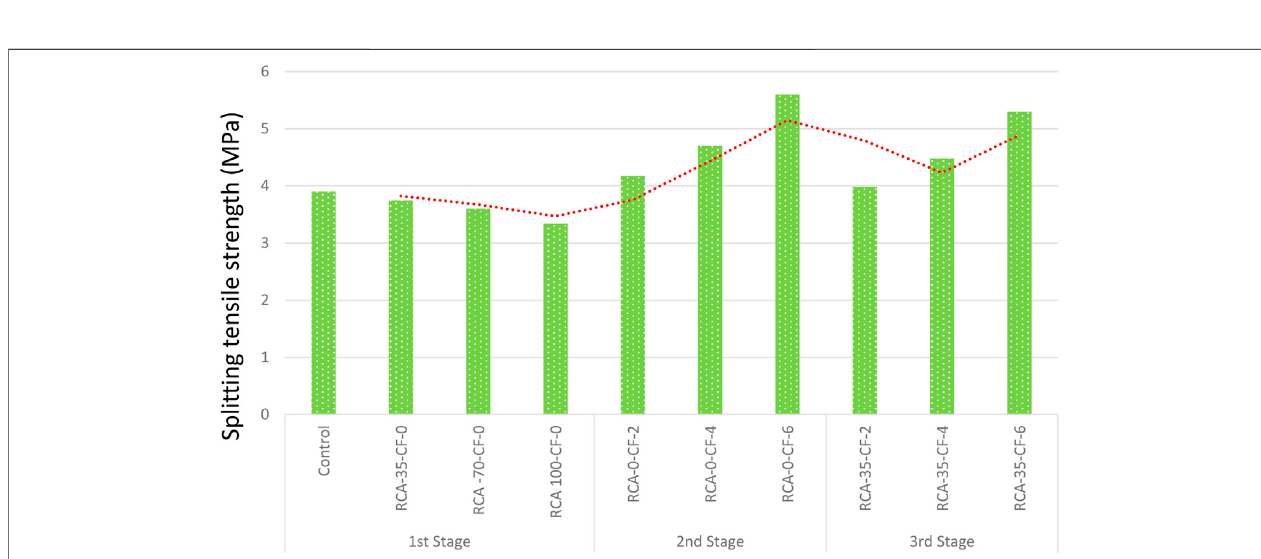
FIGURE 6 | Comparative analysis of present literature and current research for compressive strength (MPa) at 28 days.